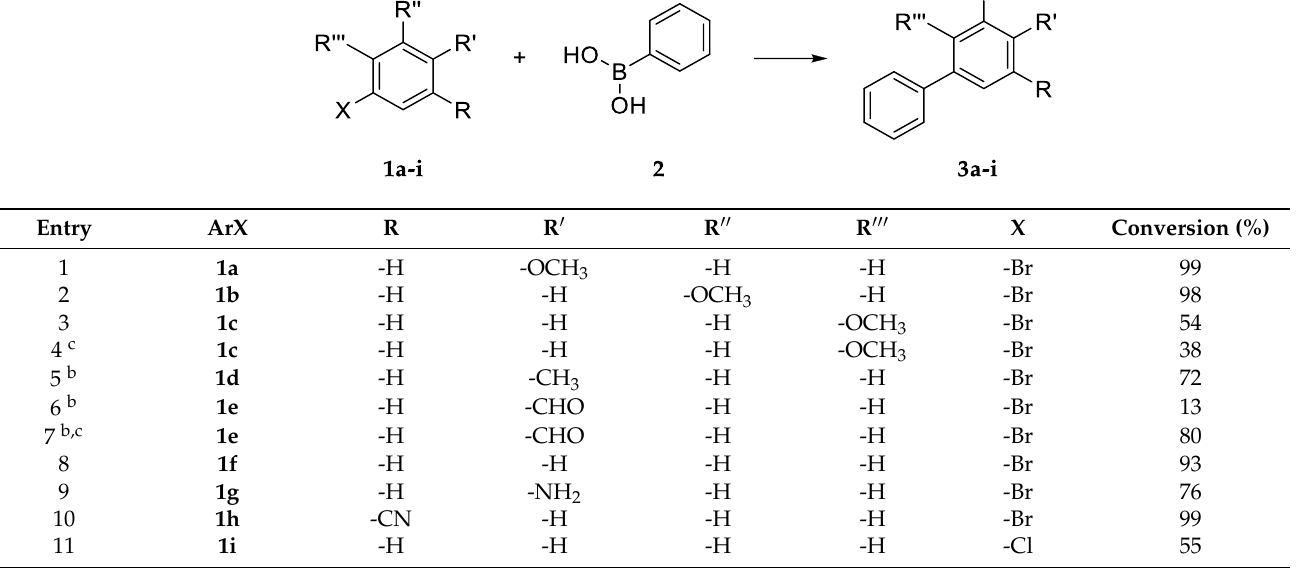
Table 5. Suzuki – Miyaura cross-couplings of ArX and PhB(OH) 2 catalyzed by Table 5. Suzuki–Miyaura cross-couplings of ArX and PhB(OH) 2 catalyzed by CNS-Pd a .